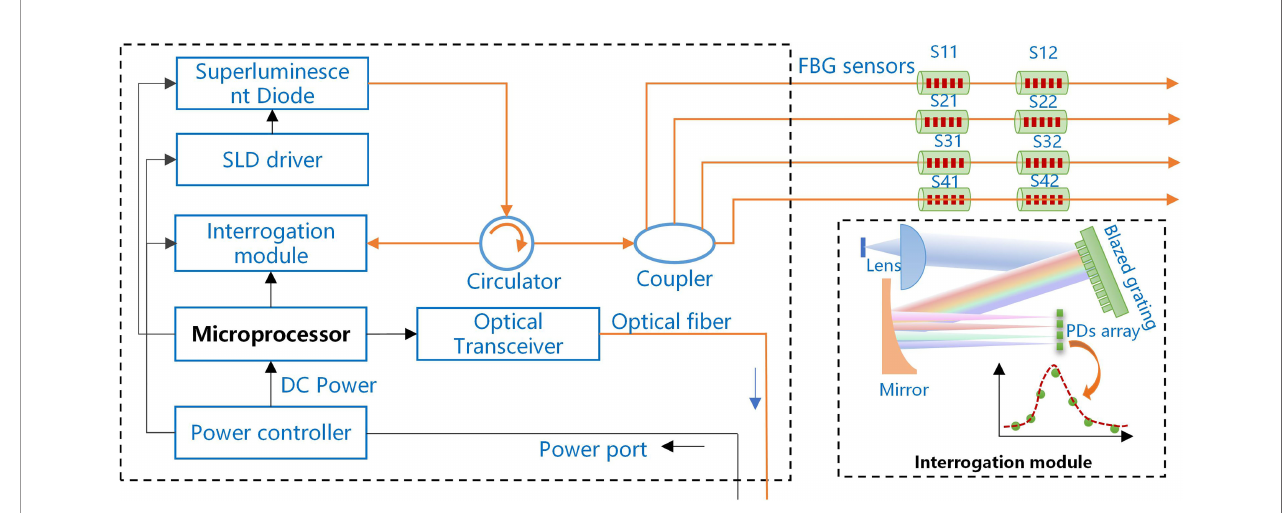
FIGURE 2 | Schematic layout of the proposed interrogation